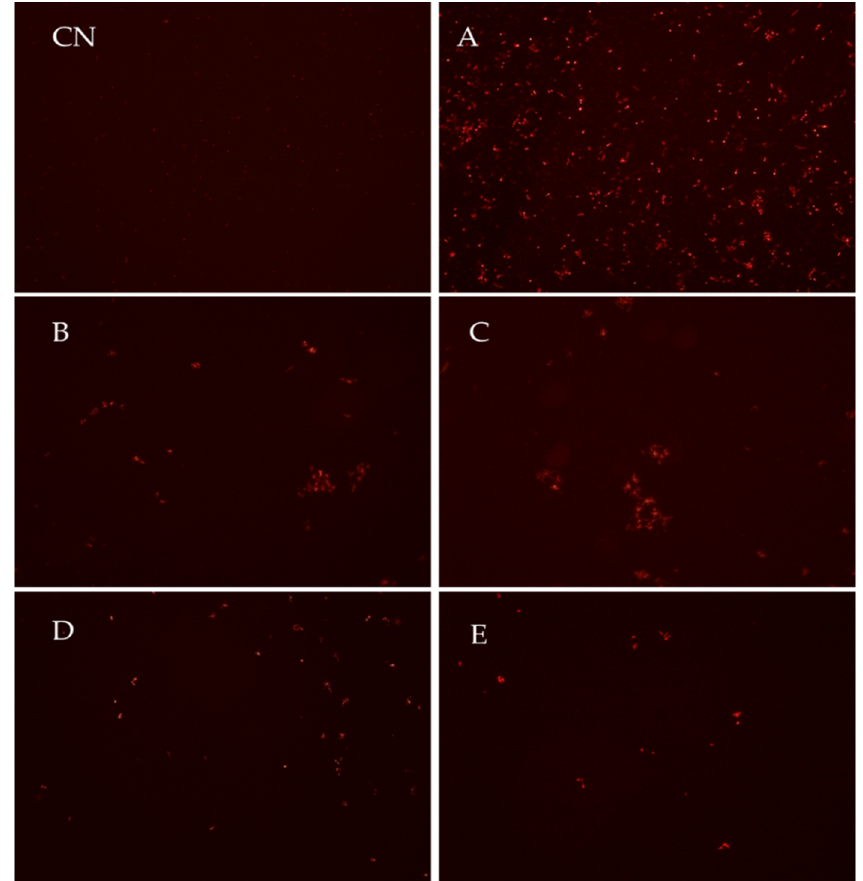
Figure 3. Viability of A. baumannii ATCC 19606 biofilm treated with different disinfection protocols (( A ) solitary ozone, ( B ) solitary citric acid, ( C ) citric acid–ozone, ( D ) ozone–citric acid, ( E ) citric acid–ozone–citric acid) using propidium iodide staining. The control group was non-treated biofilm ( CN ). Red fluorescence indicates dead cells with permeable membranes. Magnification 20×.